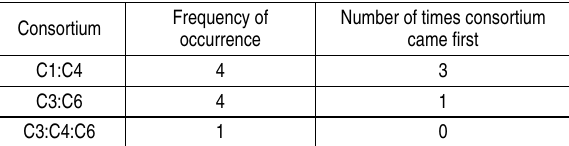
Table 26. Summary of consortia formation